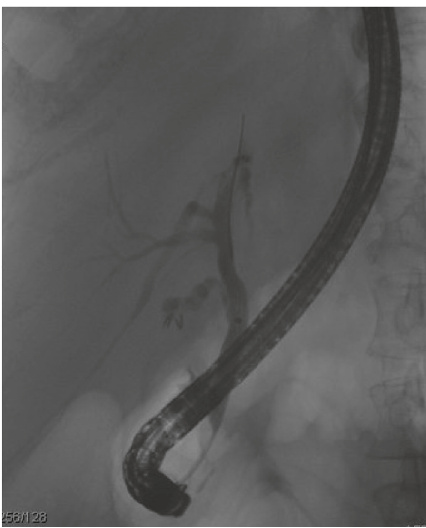
Figure 3: ERCP Fluoroscopy showing biliary tree with no abnor- malities. However when the left intrahepatic duct was swept with a 9-12 balloon, a small amount of blood and a blood clot was